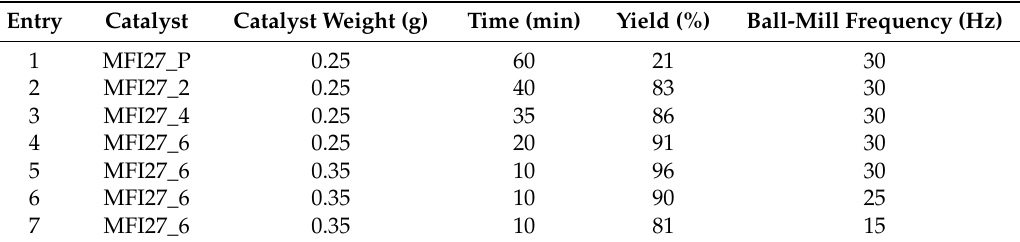
Table 3. Optimization the reaction conditions for the Biginelli reaction.